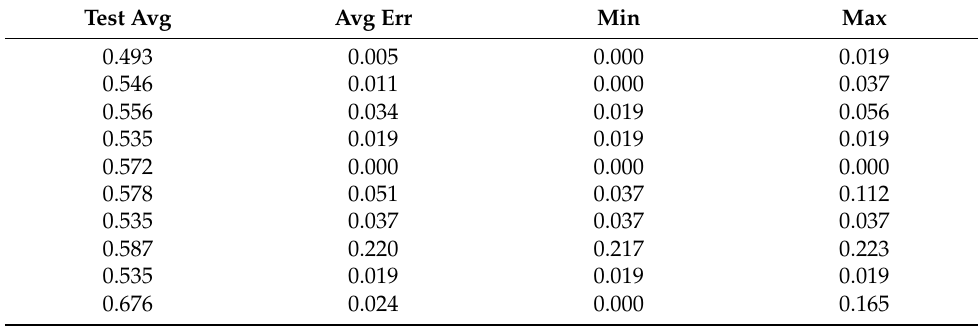
Table A205. Set 3, trials 31–40 data (single 0.5 PR value).